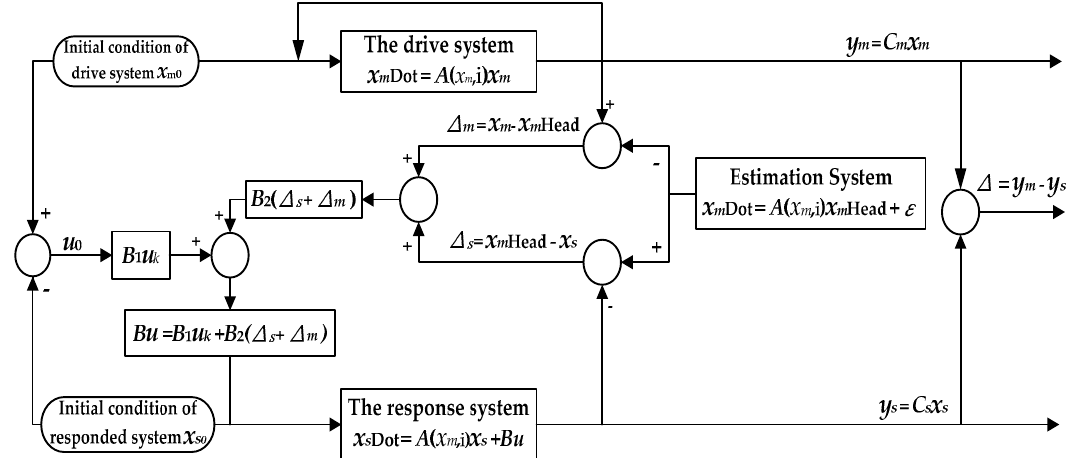
Figure 1. The iterative learning control algorithm.